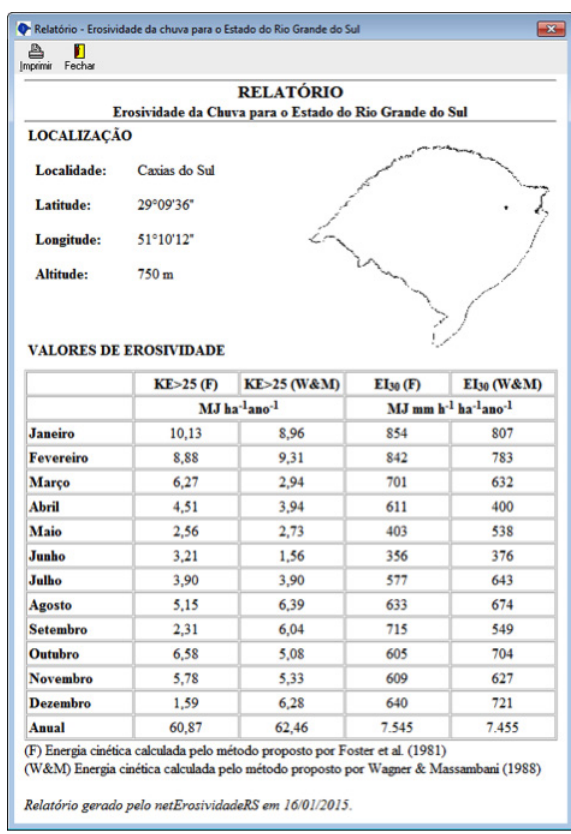
Figure 2. Report generated by netErosividade RS for Caxias do Sul, RS,